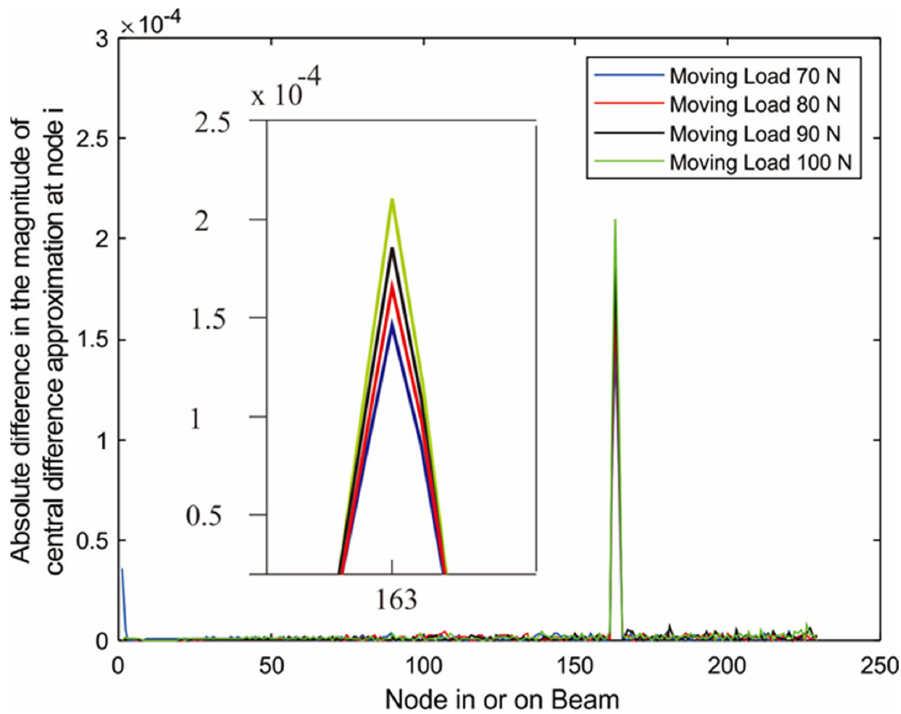
Figure 16. Absolute difference between the central difference approximation of displacement of the uncracked and the cracked (Node 163) cantilever beam subjected moving load.